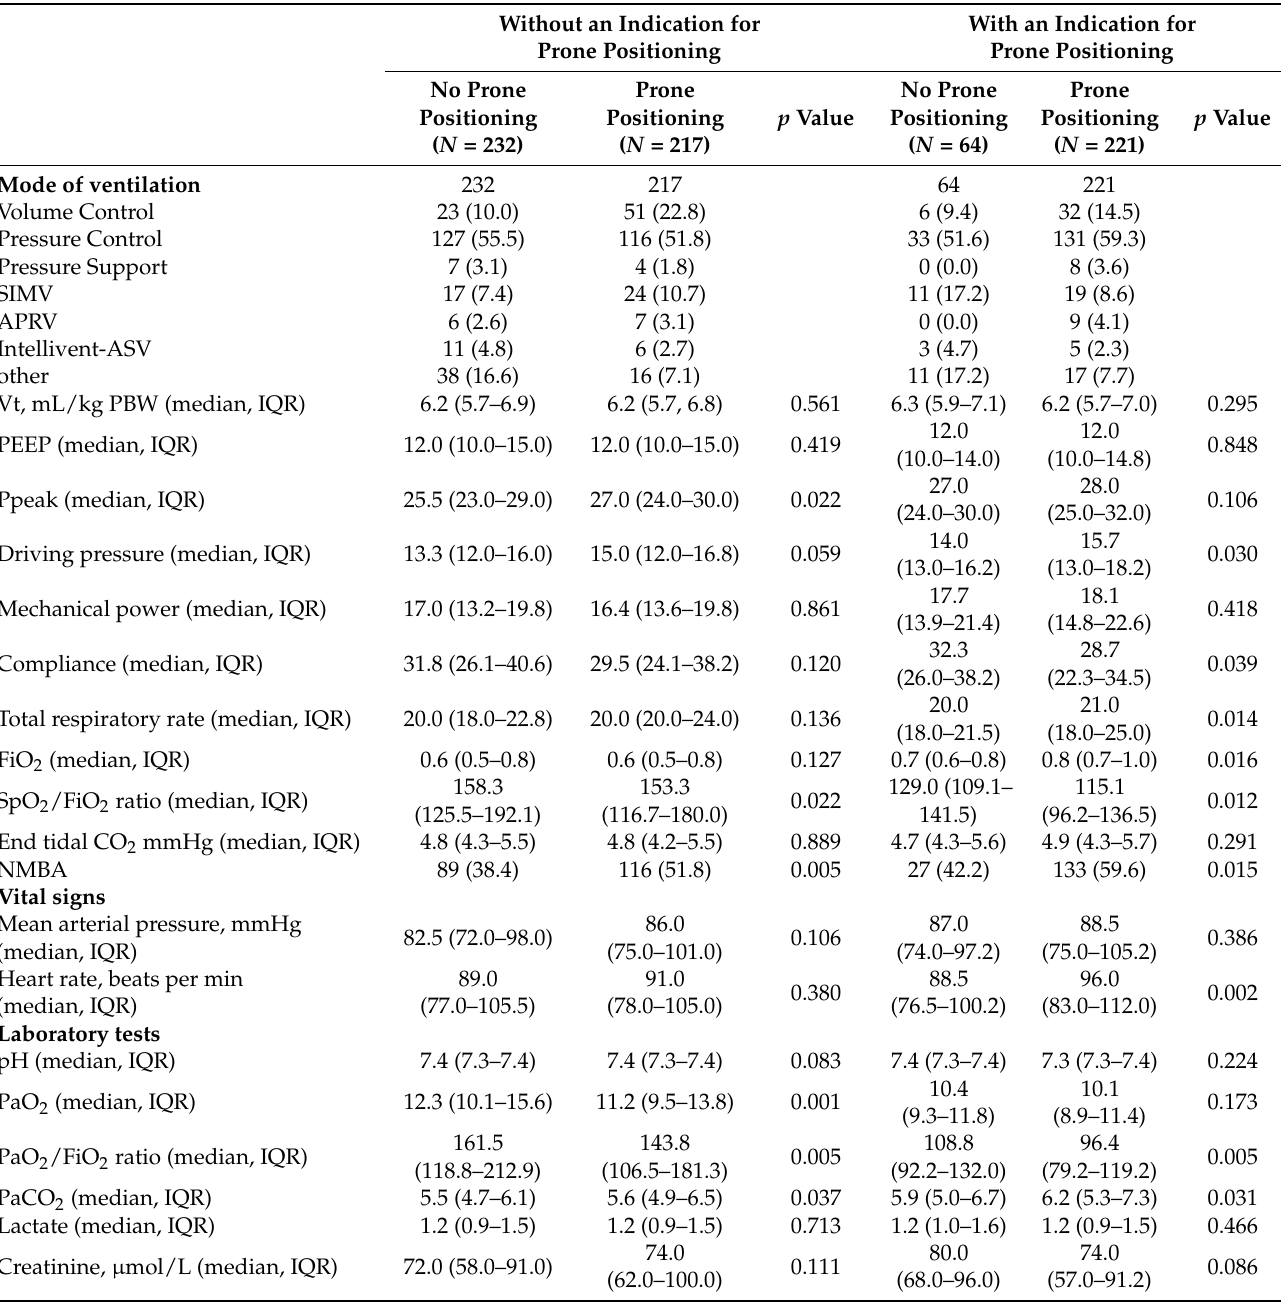
Table 3. Ventilatory Characteristics at Start of